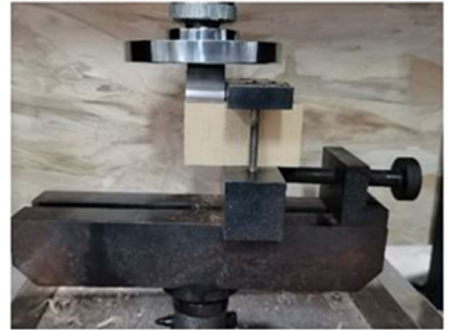
Figure 1. Test setup of block shear